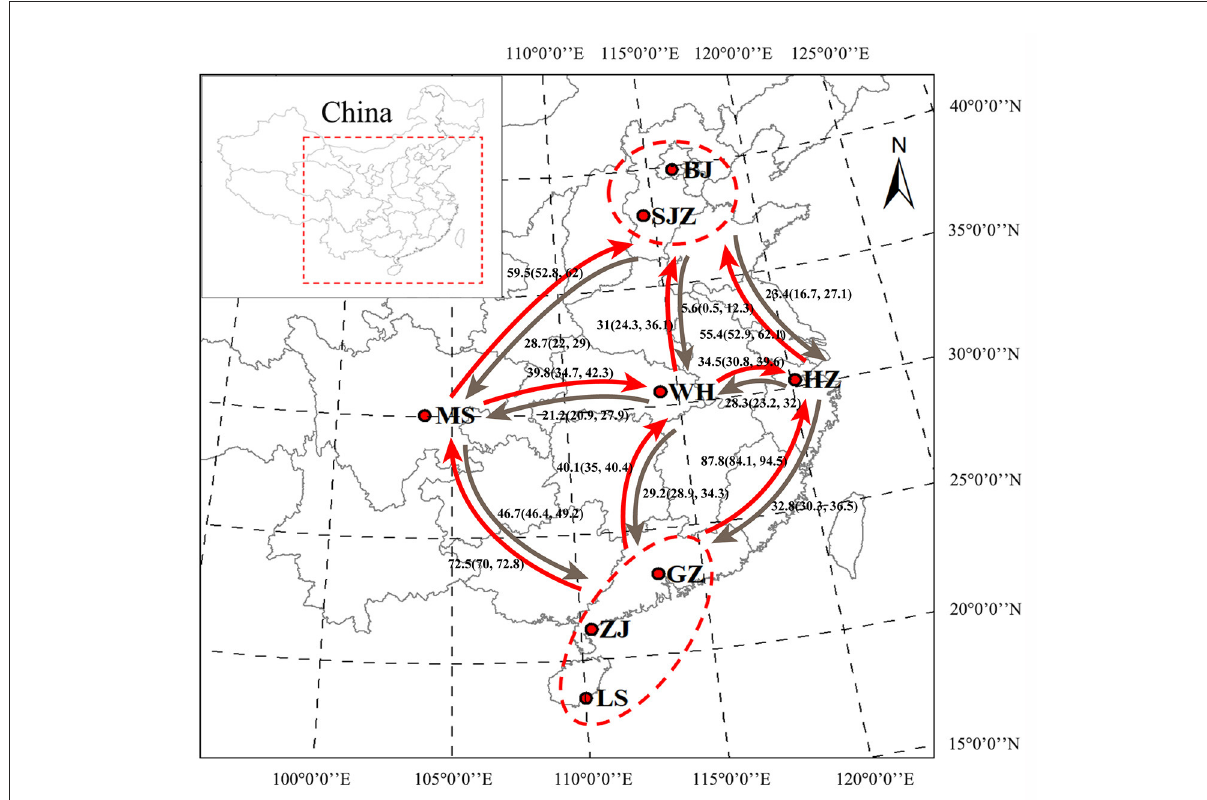
FIGURE1 Geographical locations of Ae. albopictus sampling sites in China. Bayesian estimates of historical asymmetrical migration between five locality groups of Ae. albopictus on the basis of the genome-wide SNPs. The numbers indicate migration rate, and arrows indicate the direction of migration. BJ, Beijing; SJZ, Shijiazhuang; HZ, Hangzhou; WH, Wuhan; MS, Meishan; GZ, Guangzhou; ZJ, Zhanjiang; LS, Lingshui. The map was generated using ArcMap 10.2.2 software. Map source: ESRI (available at: